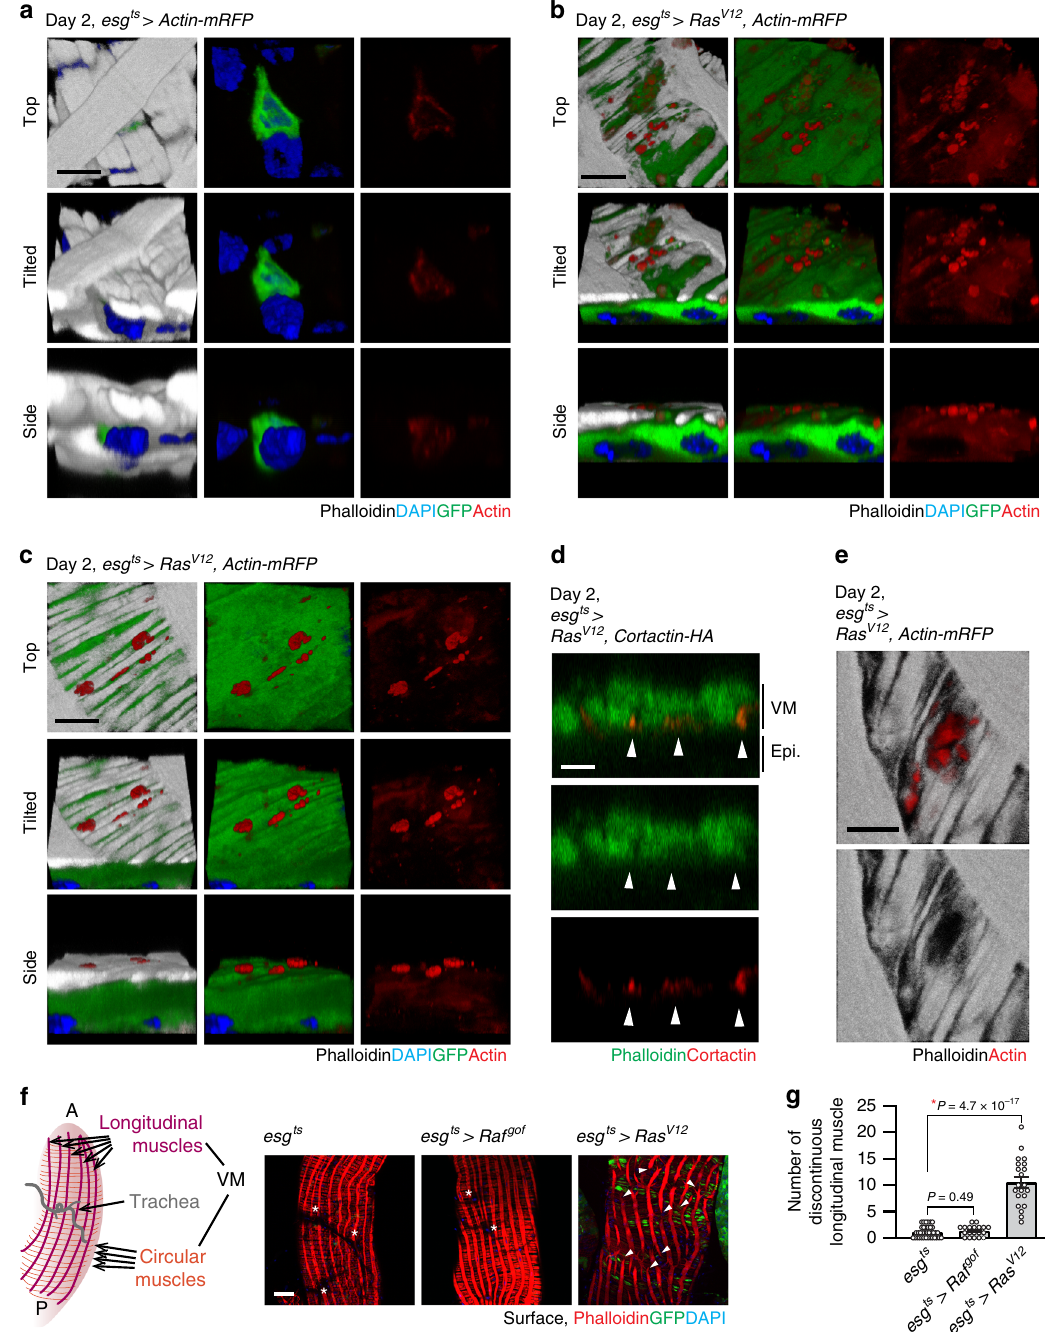
Fig. 3 Basal actin-rich protrusions disrupt visceral muscle integrity. a – c 3D reconstructions of confocal images angled at 0, 45, and 90 degrees for top, tilted, and side views, respectively. Representative images of control cells ( a ), and Ras V12 cells ( b , c ) are shown. Dissected guts are imaged for actin-mRFP (red), phalloidin (gray), and DAPI (blue). Scale bars, 5 µ m. d Orthogonal view of cortactin-rich protrusions and VM layer. Arrowheads indicate cortactin- rich protrusions (red) co-stained with phalloidin (gray). Scale bar, 5 µ m. e Surface view of a rupture in the VM layer induced by a cluster of actin-rich protrusions (red). Scale bar, 5 µ m. N = 12 ( esg ts > Actin-mRFP ) for ( a ) and N = 28 ( esg ts > Ras V12 , Actin-mRFP ) biological replicates for ( b ), ( c ), ( d ), and ( e ). f Surface views of the posterior midgut. Schematic illustration describes the architecture of the Drosophila VM. VM (red) is visualized with phalloidin. Arrowheads show discontinued longitudinal muscles. The region void of phalloidin signals (asterisks) is where the trachea is present. Longitudinal and circular muscles behind trachea are not captured because they are at different focal planes. g Quanti fi cation of longitudinal muscle breaks. Discontinuation of longitudinal muscles in one layer of VM in the area captured with 40× objective (388 µ m × 388 µ m) was counted. N = 37 ( esg ts ), N = 19 ( esg ts > Raf gof ), N = 21 (day 1, esg ts > Ras V12 ) biological replicates. Mean± SEMs are shown with individual data points. Data were analyzed by two-tailed unpaired Student ’ s t -test. Asterisks indicate statistical signi fi cance (* P < 0.01), and P values are indicated in graph, transgenes were induced with esg ts for 2 days at 29 °C. In the side views of ( a – d ), the basal side of epithelia is positioned